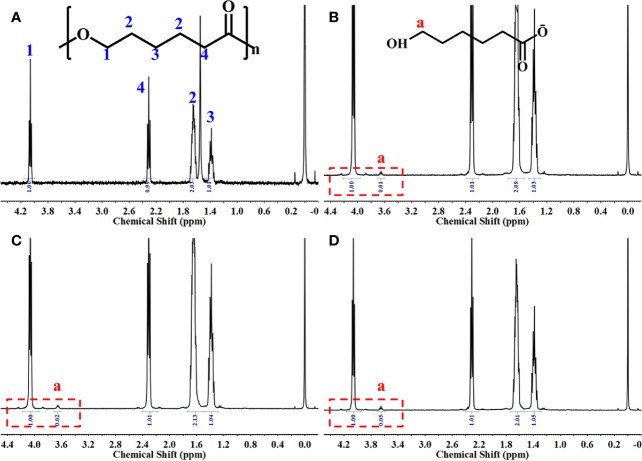
1H-NMR spectrum of the samples. Original poly(ε-caprolactone) (PCL) scaffolds (A), PCL scaffolds etched by NaOH for 5 (B), 15 (C), and 30 min (D).